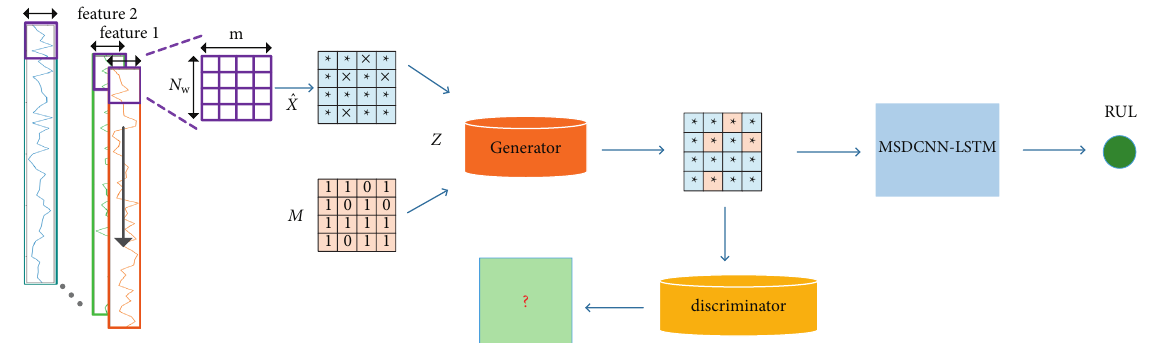
Figure 3: RUL prediction framework based on the GAIN and